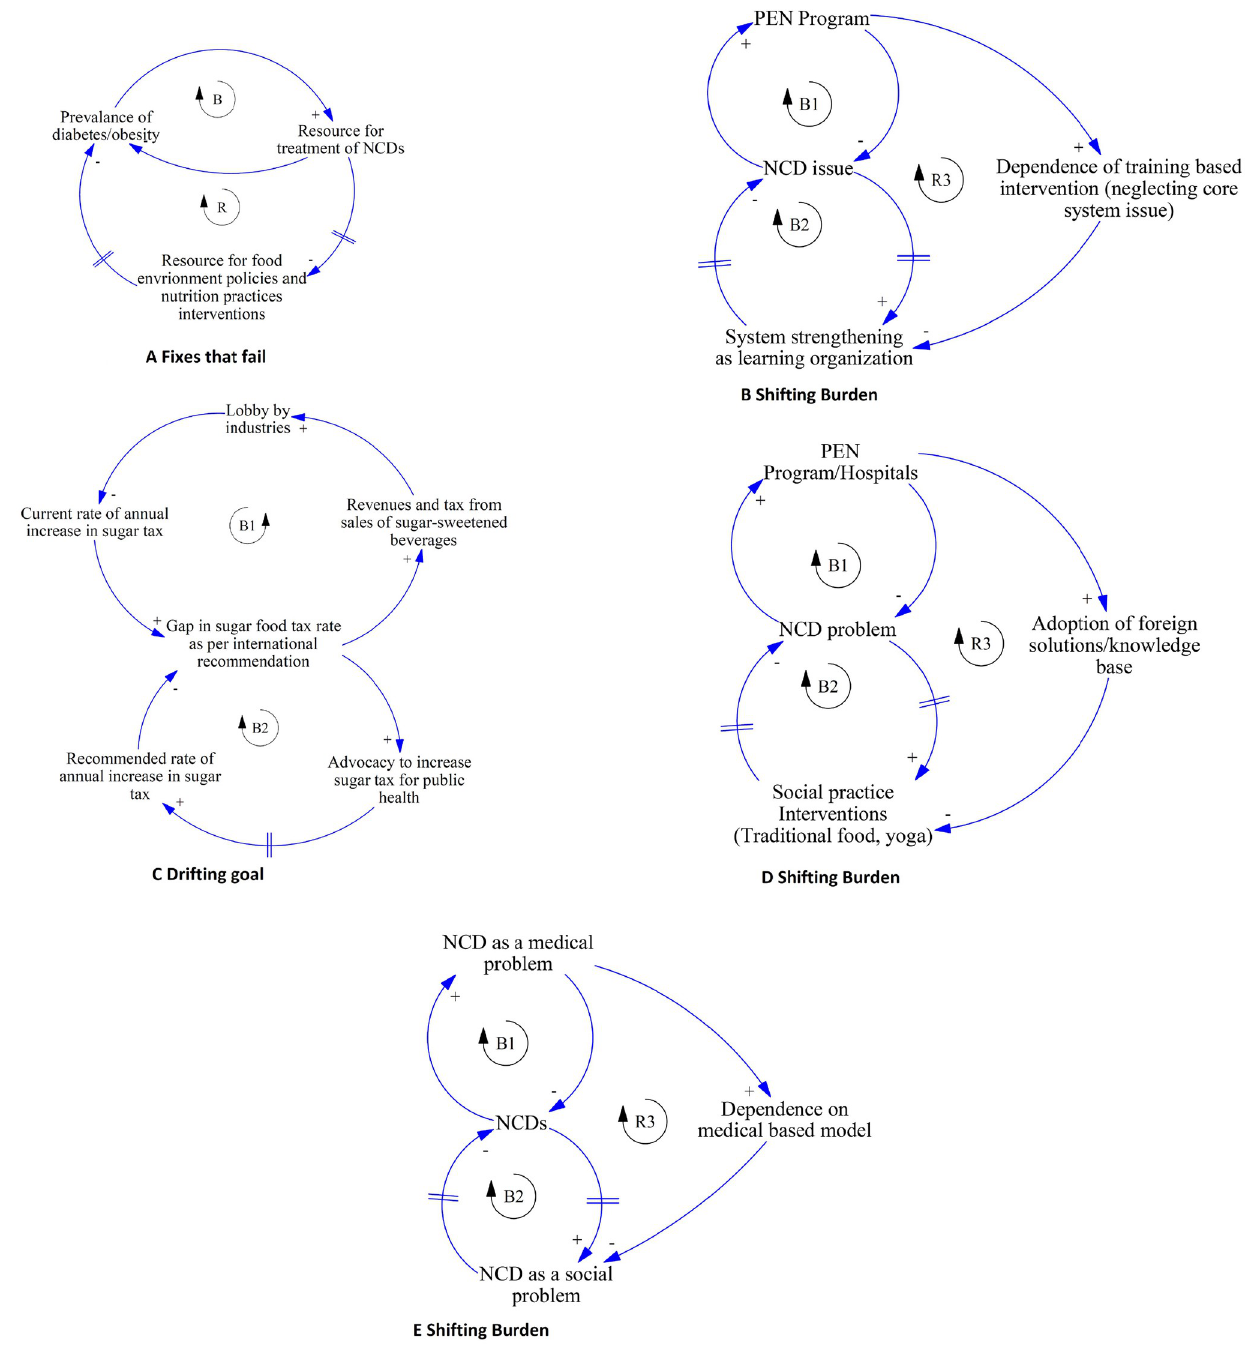
Fig 6. System archetypes showing different mechanisms of influence of dietary and physical activity practices on